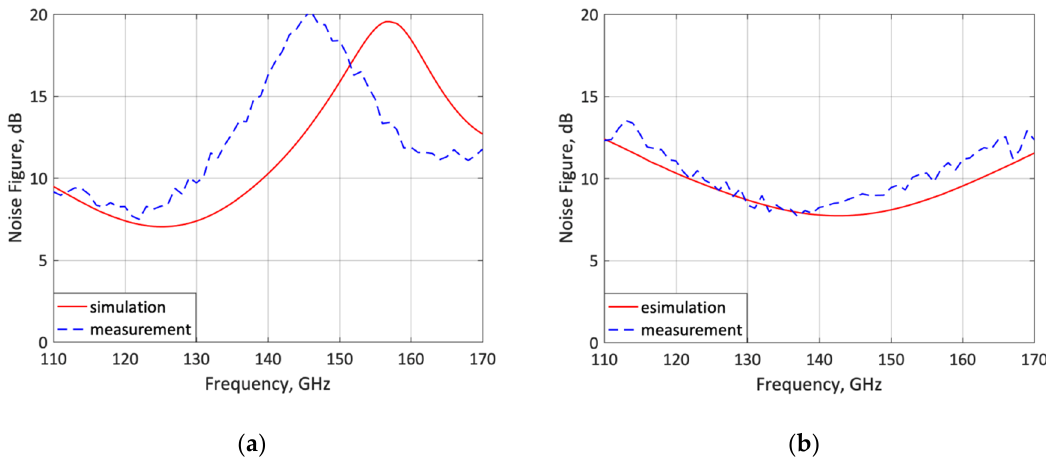
Figure 11. Measured and simulated LNA noise figure. ( a ) Lower-frequency state (120 GHz); ( b ) upper-frequency state (140 GHz).